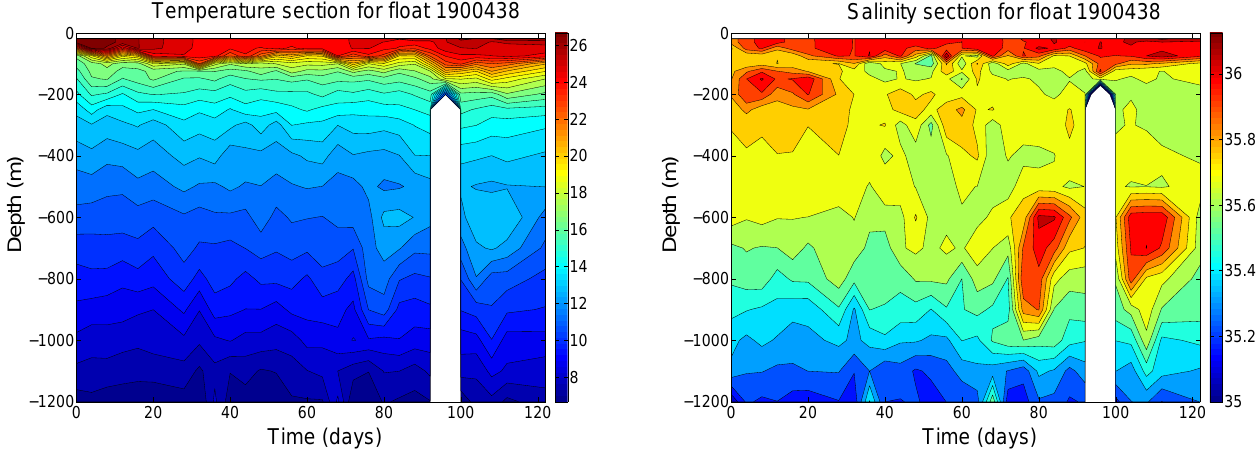
Fig. 20. Vertical sections of temperature (in ◦ C, left) and of salinity (right) along float 1900438 trajectory. Figure 20: Vertical sections of temperature (in o C , left) and of salinity (right) along float 1900438 trajectory. the winter monsoon. This can be related with the presence of cyclones at this location, already described by Bower and Furey